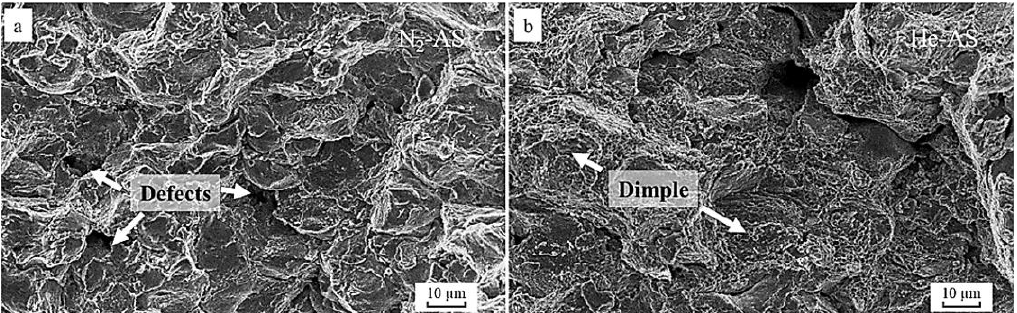
Figure 11. The fracture morphology of ( a ) nitrogen- and ( b ) helium-fabricated CS IN 718 deposits. Reprinted from Ma et al. [78], Copyright 2019, with permission from Elsevier.